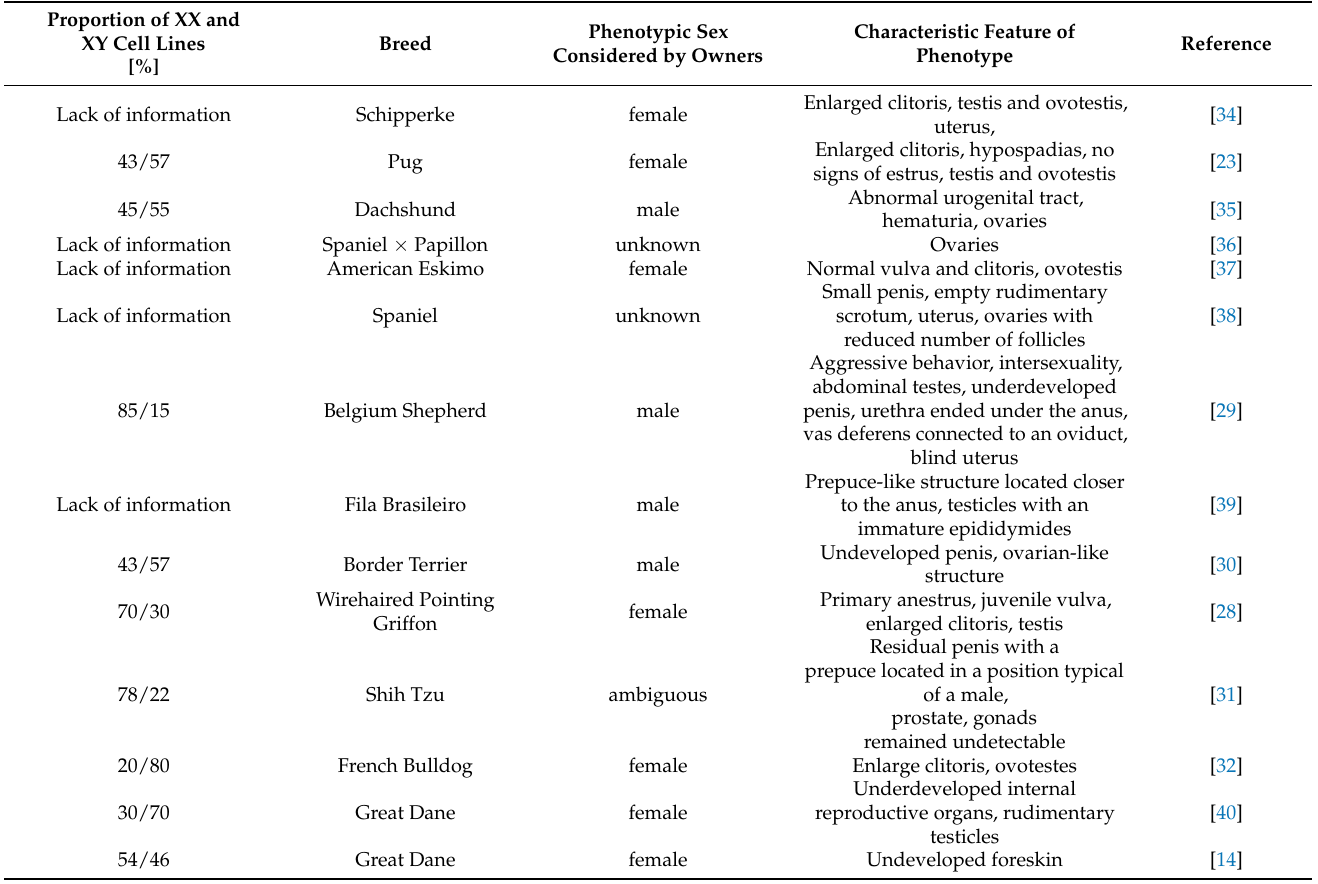
Table 4. Leukocyte chimerism XX/XY reported in